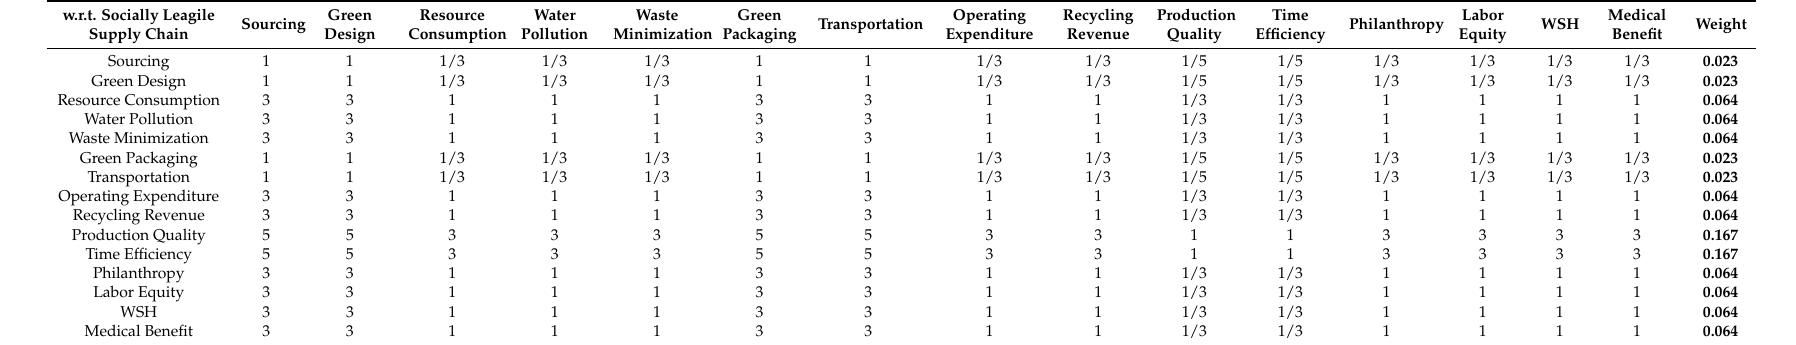
Table 14. Pairwise comparisons of the criteria w.r.t. Socially Leagile supply